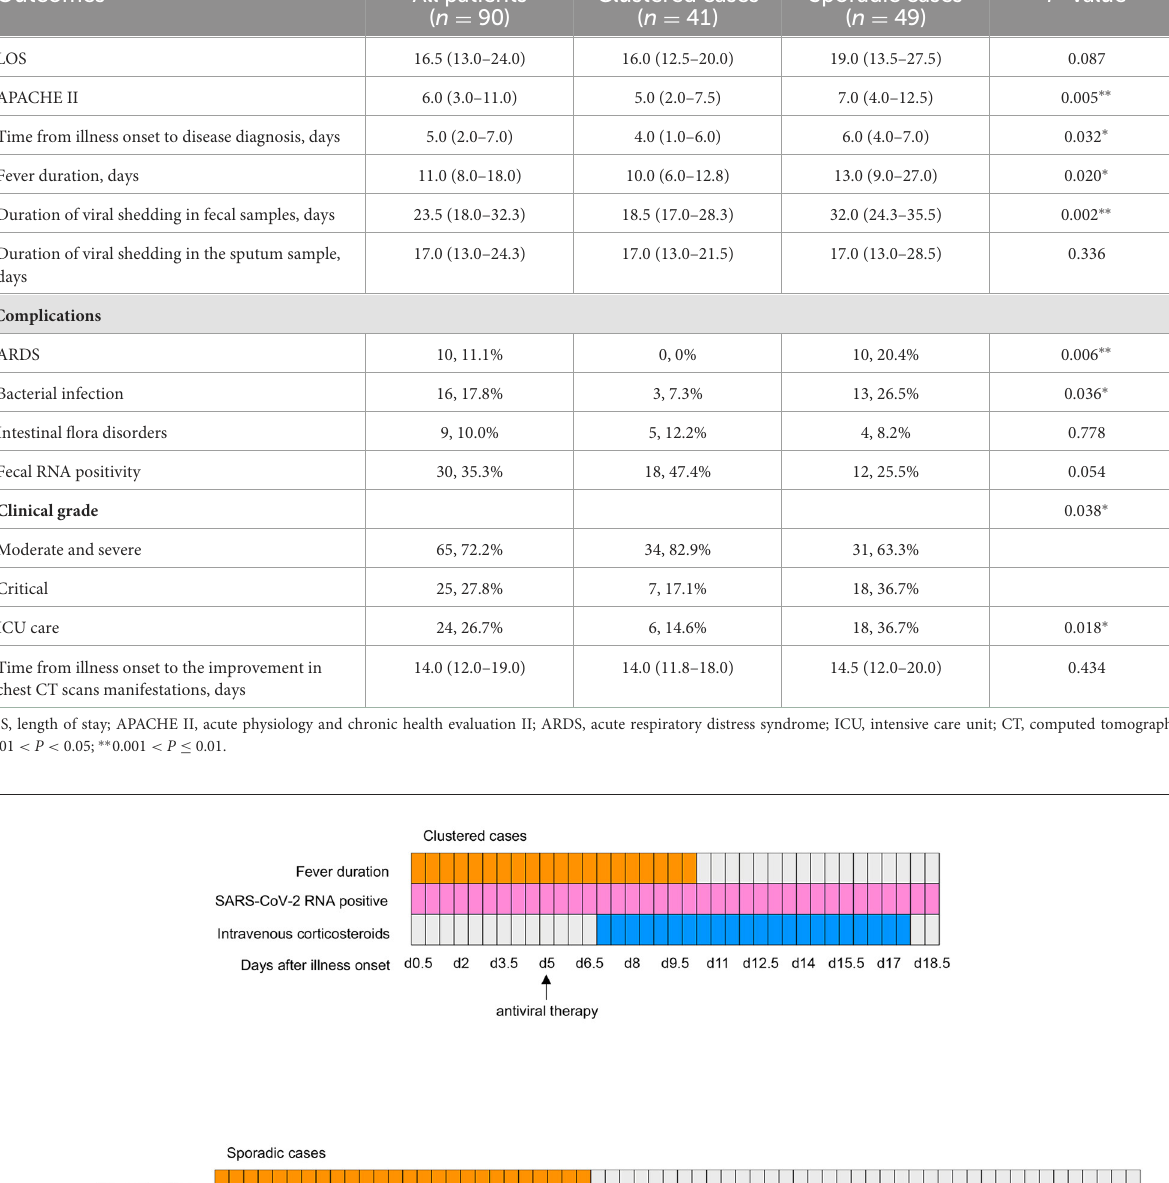
with pulmonary vascular permeability, increased lung weight, and loss of aerated lung tissue, and its 28-day mortality rate is up to 50%